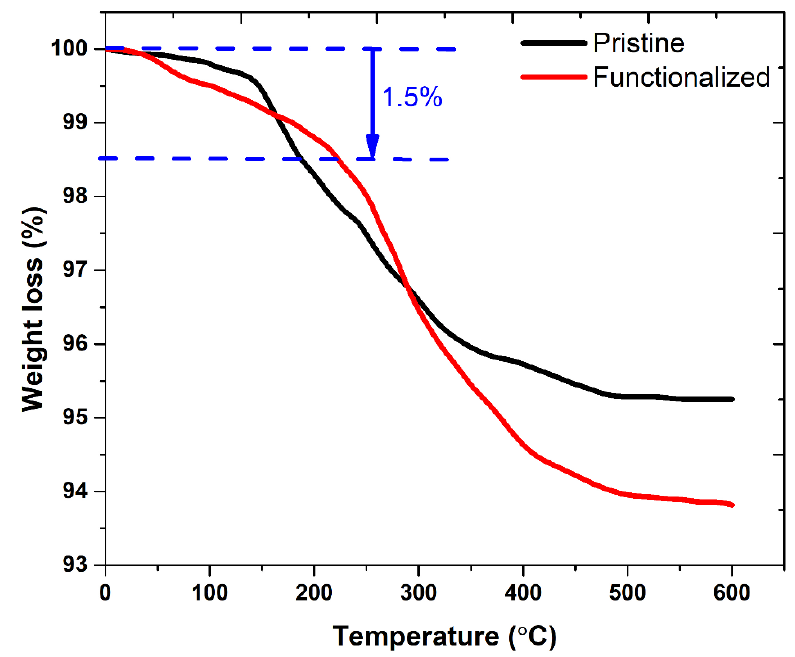
Figure 2. TGA profiles of pristine and amine-functionalized adsorbents.